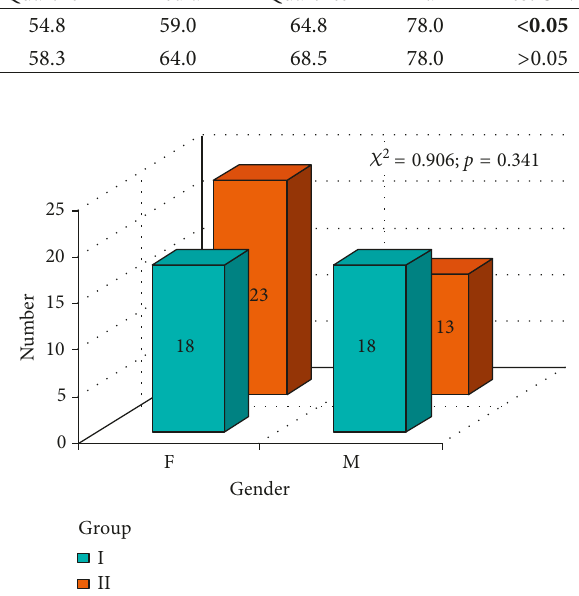
Figure 4: Gender and χ 2 test results, comparison of both groups I and II.